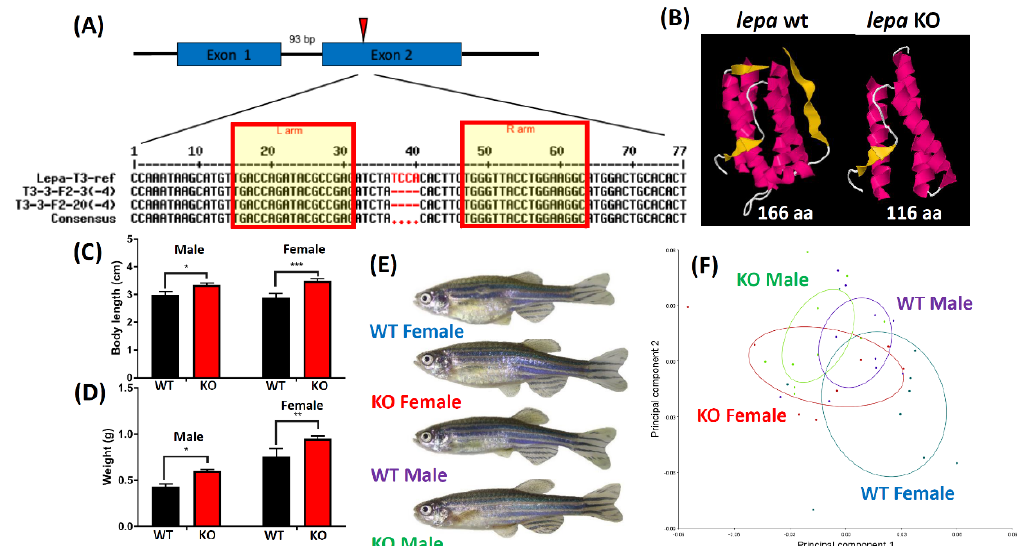
Figure 1. Generation and phenotype analysis of lepa KO zebrafish. ( A ) Schematic showing the TALEN left and right arm sequences used to target lepa gene on exon 2 in zebrafish. ( B ) Three-dimension model showing the predicted protein structure between wild type and lepa KO fish. ( C ) Comparison of body length and ( D ) body weight between wild type and lepa KO fish at six-month-old aged. ( E ) Appearance of wild type and lepa KO fish at six-month-old aged. ( F ) Morphometric analysis of wild type and lepa KO fish at six-month-old aged.